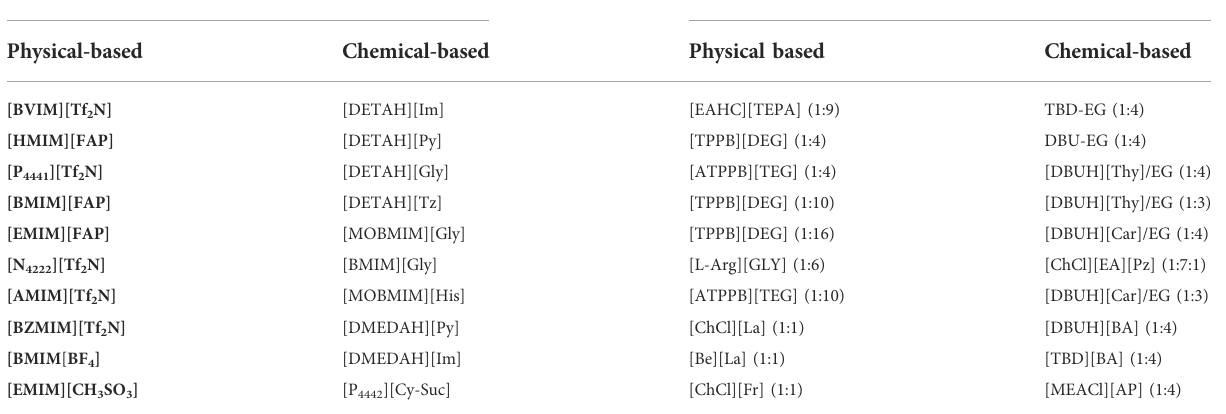
TABLE 6 Suggested top 10 ILs/DESs. ILs DESs Physical-based Chemical-based Physical based Chemical-based